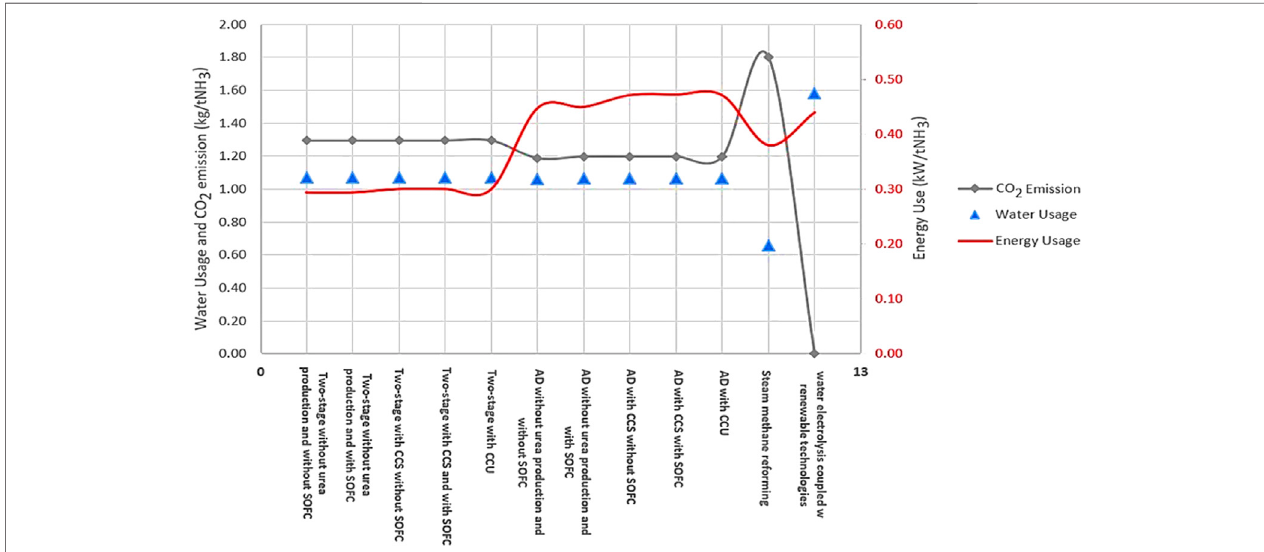
FIGURE 9 | A comparison of different proposed ammonia production processes with conventional methods in terms of carbon dioxide emissions, water, and energy usage.